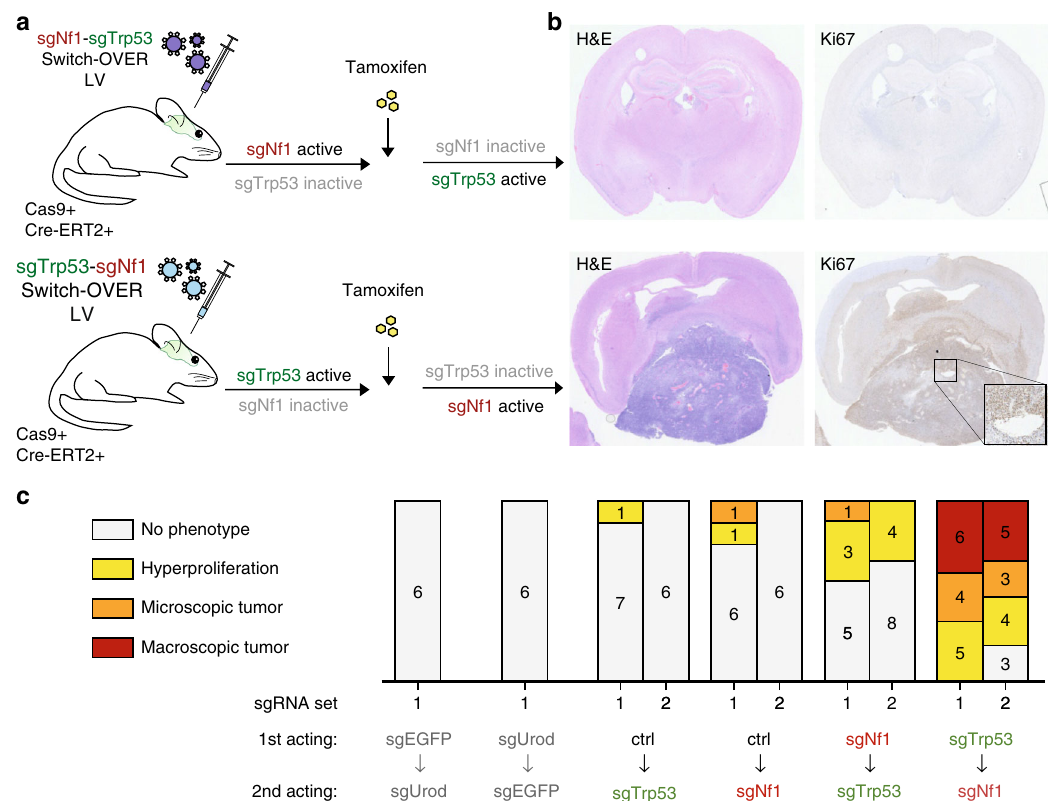
Fig. 5 Recombinase-mediated consecutive editing in vivo. a In vivo Nf1 / Trp53 mutant GBM mouse model. Schematic of experimental setup. Lentiviral particles encoding Switch-OVER constructs were injected into the right ventricle of Cas9-GFP; Nestin-CreERT2 mice at postnatal day (P) 0 with indicated dual sgRNA lentivirus. At P21, mice were treated with tamoxifen and followed for 8-10 months. b Representative images showing coronal full brain section stained with H&E as well as anti-Ki67 antibody. ( c ) Stacked bar graph shows frequency of tumors and hyperproliferation in 8-month-old mice (numbers correspond to number of animals) transduced with the indicated dual sgRNA lentiviral constructs. Except for Urod / EGFP combinations, two different sets of sgRNA sequences were used as